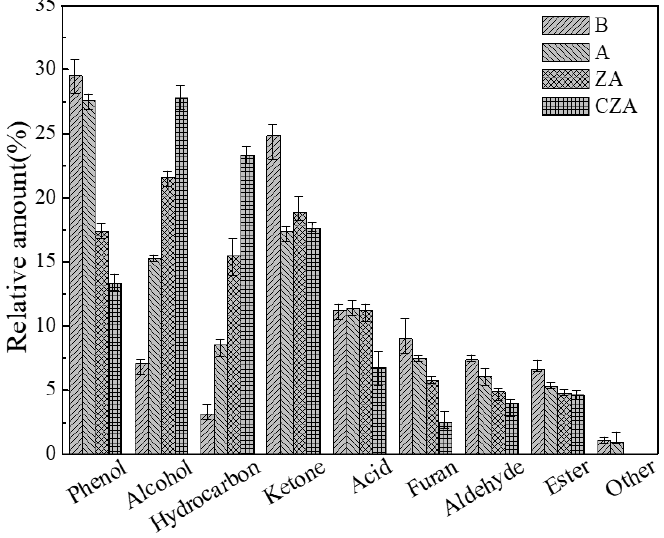
Figure 4. Change in relative amount of pyrolysis products.